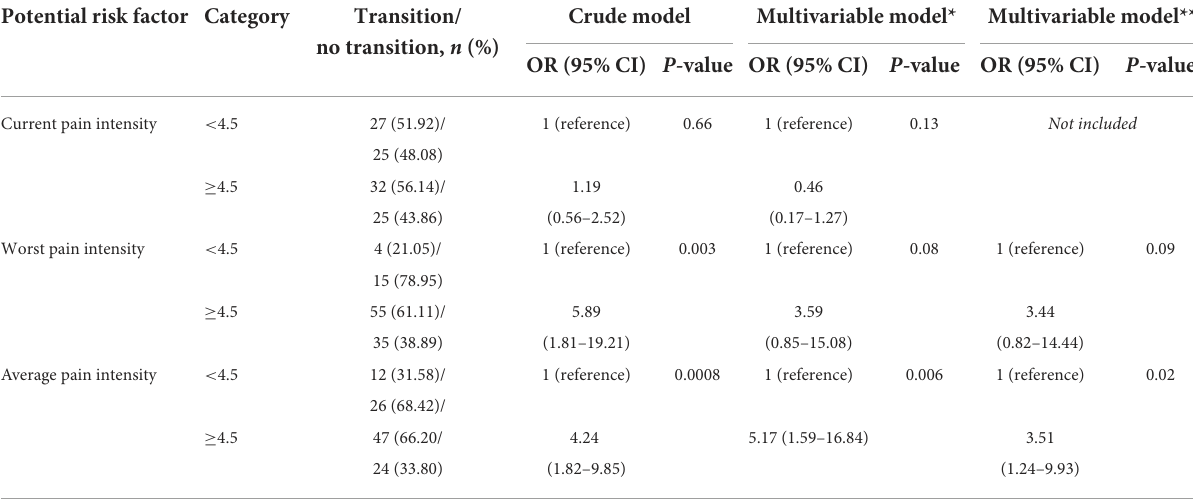
TABLE 2 Binary logistic regression analyses assessing the association between current, worst and average pain intensity and the acute to chronic transition at 3 months of follow-up. Potential risk factor